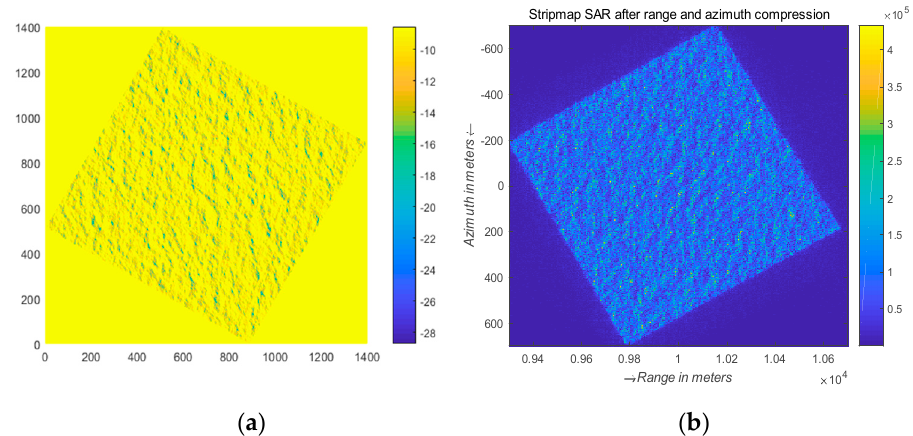
Figure 8. Data observed by SAR-1 as follows: ( a ) ocean surface backscattering coefficient and ( b ) ocean SAR image.